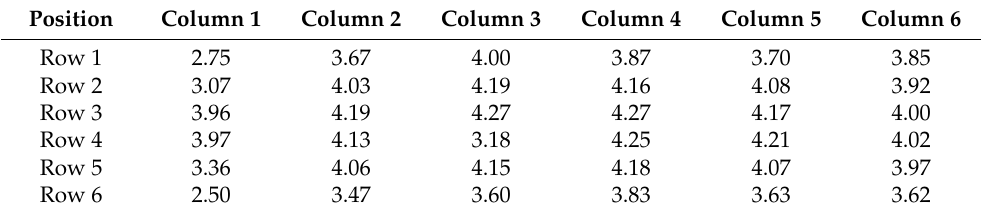
Table 5. Voltage of the photovoltaic panels under 4 times beam expansion.